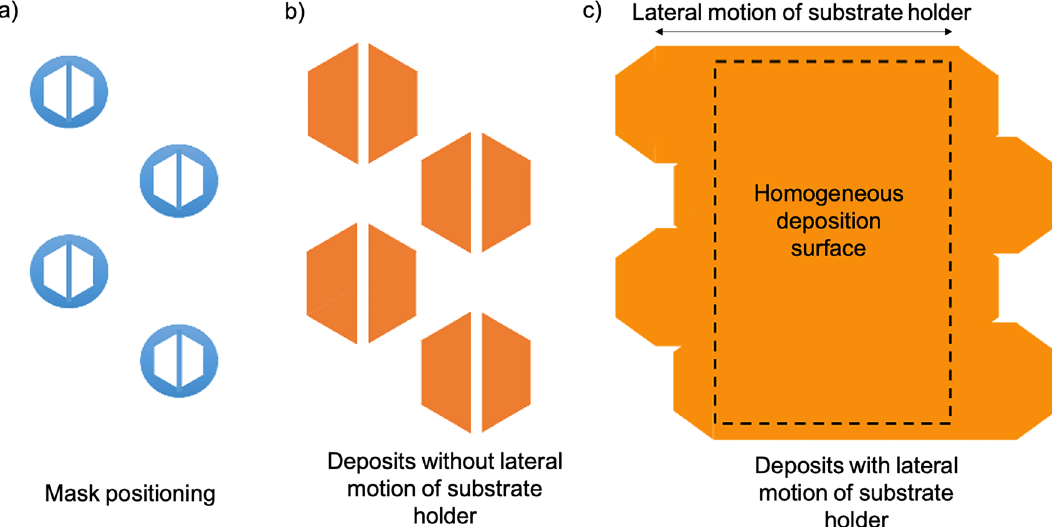
Figure 9. ( a ) Positioning and shape of the masks placed in front of the lens outlets, ( b ) shape of the corresponding deposit of nanoparticles on the substrate without lateral motion of the substrate-holder, and ( c ) shape of the deposit of nanoparticles on the substrate with the lateral motion of the